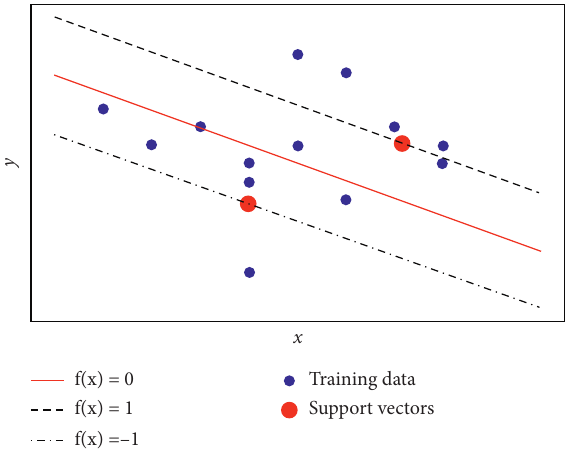
Figure 10: Schematic diagram of support vector